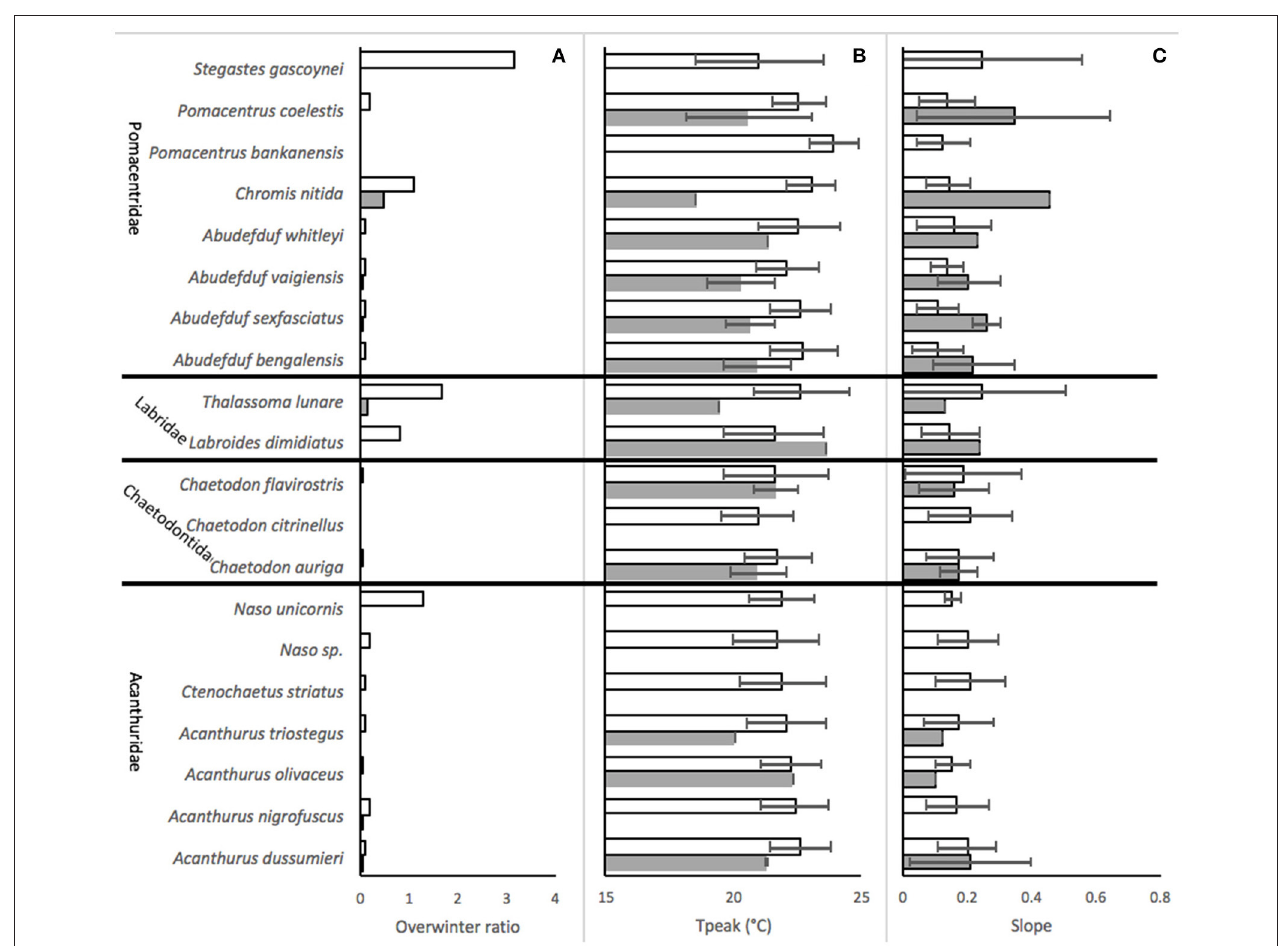
FIGURE 3 | Performance of 20 species of expatiating coral reef fish in SE Australia, (mean ± SD of values derived from all abundance series in the 2002–2017 dataset), at Sydney (empty bars) and Merimbula (filled bars), for (A) the ratio of average over winterers to recruits, (B) temperature after which abundance started to fall (T peak ), and (C) slope of relationship between temperature and proportional